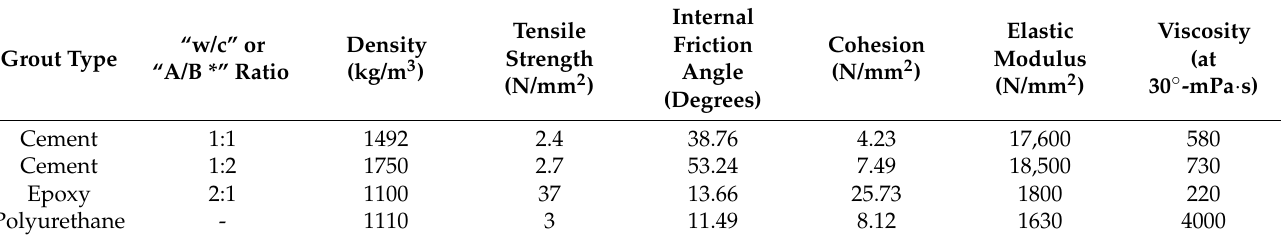
Table 2. Properties of the grouts used in this